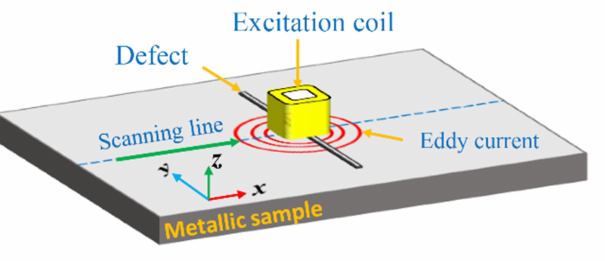
Figure 9. Simulation model for inspecting cracks with different depths on an aluminum plate. The excitation coil is placed above the sample surface with the lift-off distance of 0.2 mm.